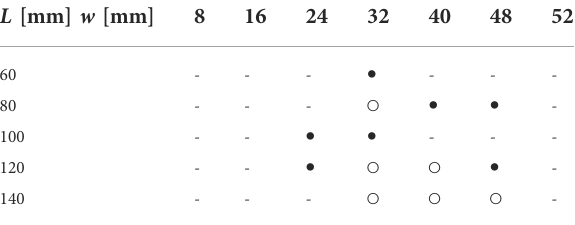
TABLE 1 Experimental result. -:Not vibrating. rates. ◦ :Vibrating.